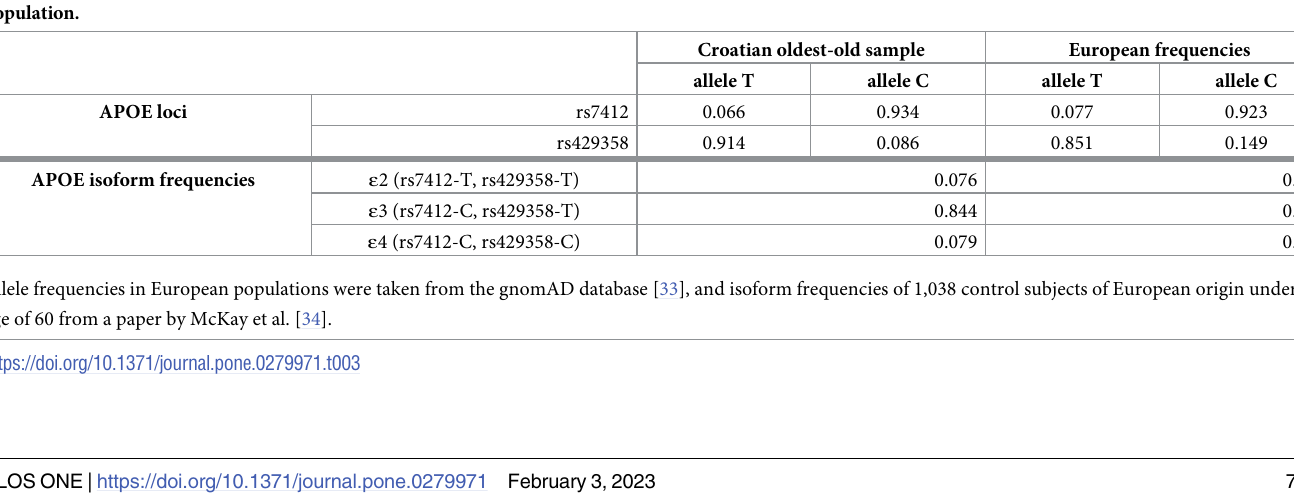
demonstrates that the weighted longevity score for the threshold of 95 years is gradual and inverse between groups below and above the median. The largest proportion of participants who died before age 90 is in the below-the-median group, and the largest proportion of those who survived over age 95 is in the above-the-median wGLS95 group. On the other hand, the weighted longevity score for the threshold age of 90 years has equal distributions between the 90.00–94.99 group and the 95.00+ group for both below- and above-the-median scores, while the proportion of people who died before 90.00 year of age is substantially higher in the below- the-median wGLS90 group.